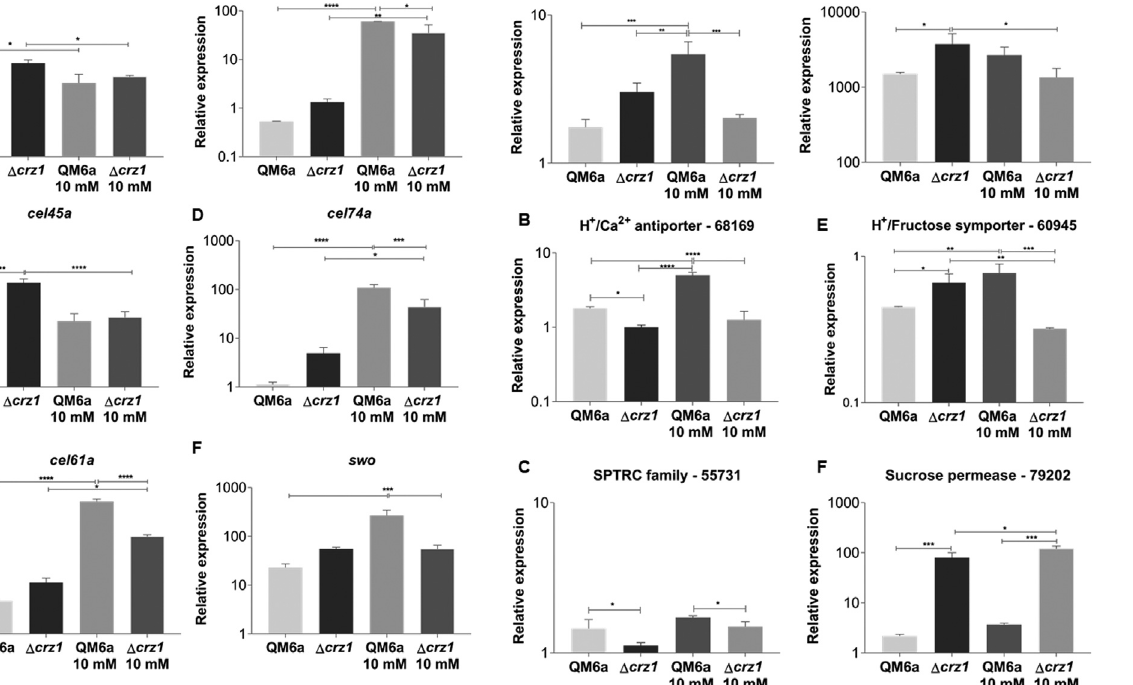
Figure 5 - Analysis of differential expression of the endoglucanases (A-C), xyloglucanase (D), LPMO CEL61A (E) and swollenin (F) from QM6a and (cid:2) crz1 T. reesei in the presence of SCB and SCB supplemented with 10 mM Ca 2+ after 8h of induction. Expression values are represented as log 10 means of three biological replicates with standard deviation nor- malized by glycerol expression levels at the same condition. Statistical significance is represented as asterisks, considering p-value as <0.05 (*), <0.01 (**), <0.001 (***) and p<0.0001